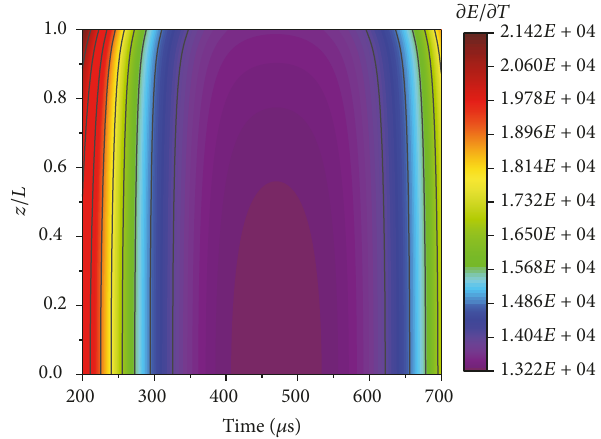
Figure 7: Spatial-temporal distribution of 𝜕𝐸/𝜕𝑇